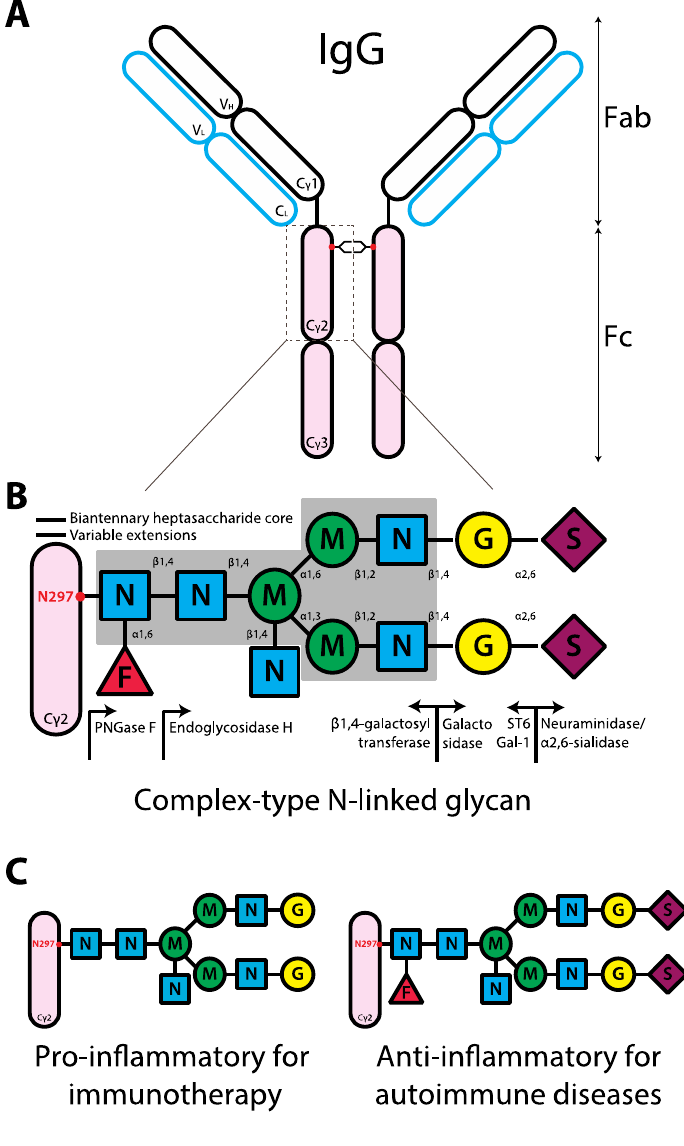
Figure 1. Schematic representation of the human IgG structure and glycan composition. ( A ) IgG structure. IgG protein is comprised of two heavy chains (black outline) and two light chains (blue outline). Each IgG heavy chain has the variable region (V ) and the H constant region containing three domains (C γ 1-3). The line between C γ 1 and C γ 2 represents the hinge region. Each light chain has variable (V ) and constant regions (C ). L L IgG molecule can be divided into antigen-binding fragment (Fab; empty ovals) and fragment crystallizable region (Fc; pink ovals). The red dot represents N-linked glycans of complex-type. ( B ) Composition of complex-type N-linked glycan on IgG. The glycan has a biantennary heptasaccharide core (solid line and in the gray block) and variable extensions (dash line). Abbreviations: F, fucose; N, GlcNAc; M, mannose; G, galactose; S, sialic acid. The enzymes, glycosyltransferases (left arrow) and glycosidases (right arrow), responsible for the addition or removal of the specific sugar are placed directly underneath of the sugar linkage. ( C ) Design of glycan composition on IgG Fc for potential antibody